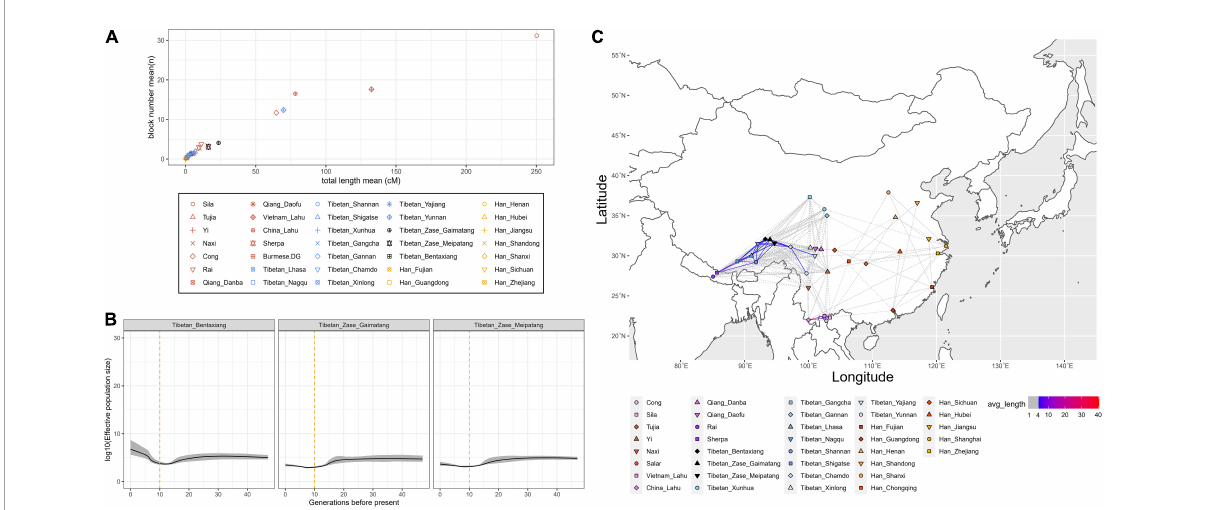
FIGURE3 Identity-by-descent (IBD) sharing-based analysis. (A) The normalized number and length (unit: cM) of IBD blocks sharing within a population. (B) Effective population size (Ne) of three studied Nagqu Tibetan populations within 30 generations before the present. (C) The normalized length (unit: cM) of IBD sharing between Sino-Tibetan populations.